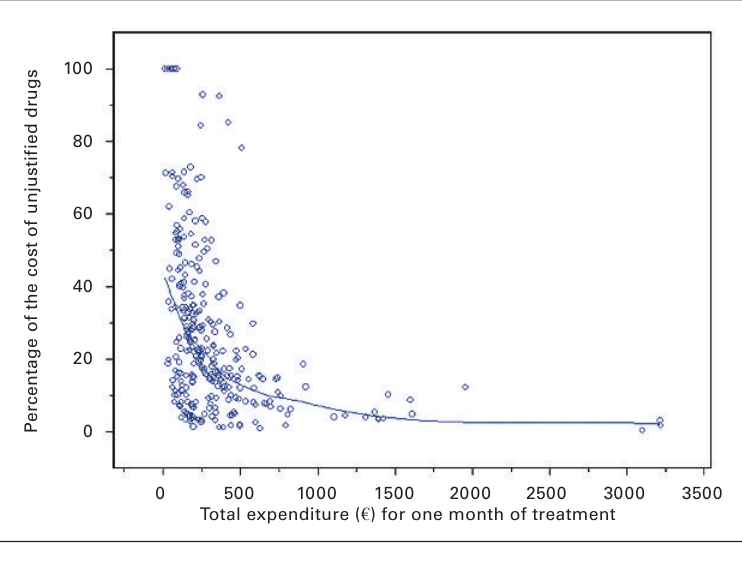
Figure 1 Percentage of the costs of unjustified drugs as a function of the individual total drug expenditure (n = 318).The fitting curve was obtained with a loess local regression